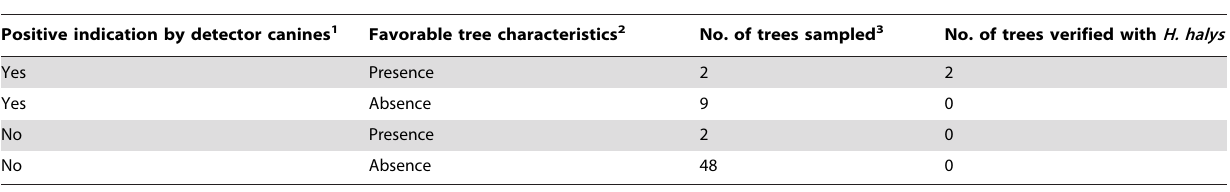
Table 2. Detection of Halyomorpha halys by detector canines from dead trees in the natural landscape.